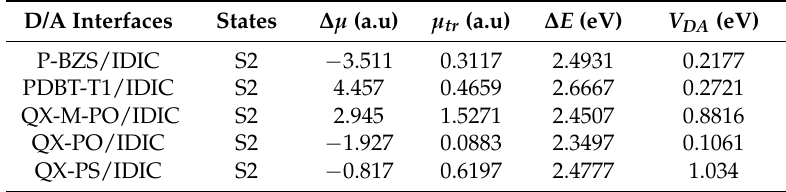
Table 12. Calculated charge transfer integrals for the polymer/IDIC interfaces. D/A Interfaces